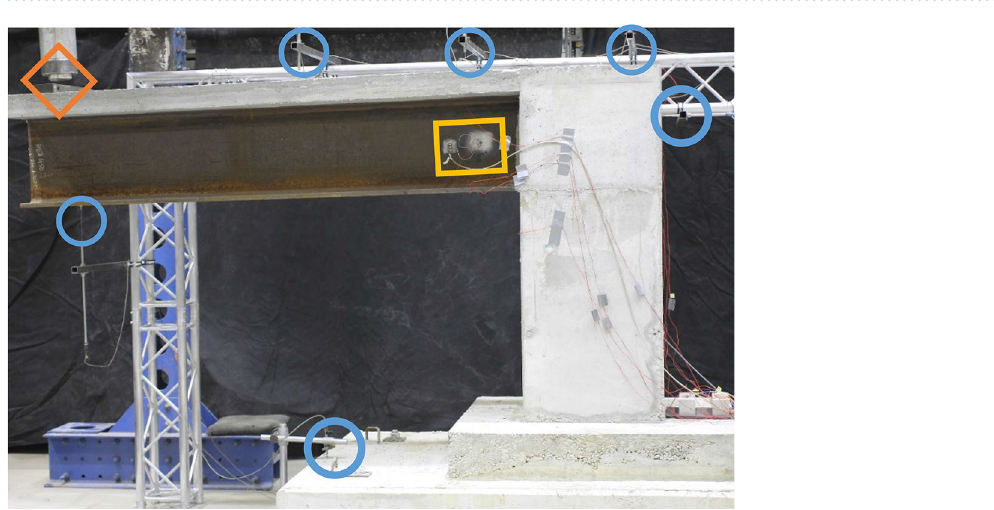
Figure 4. Sensors types and locations.